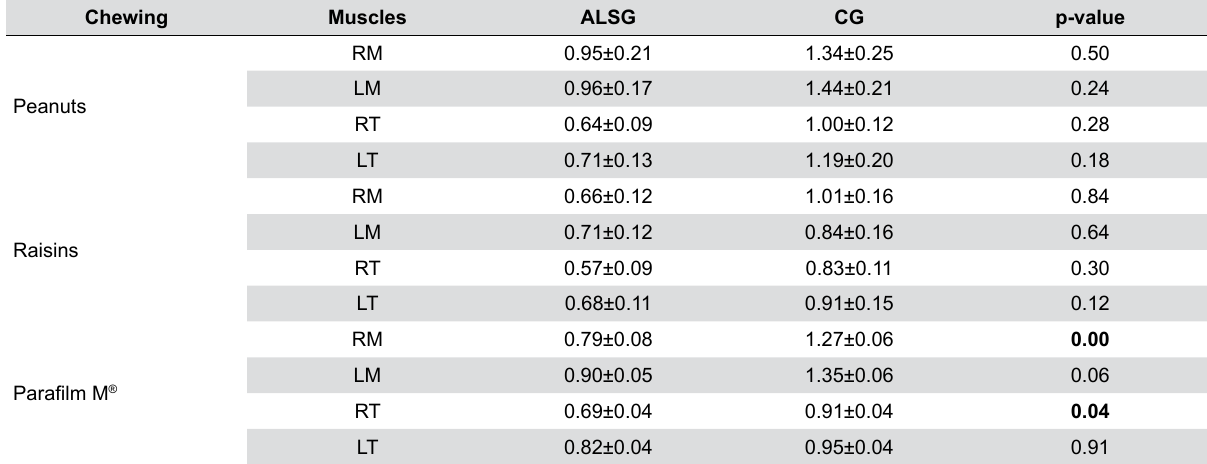
Table 3- Comparison of the mean habitual and non-habitual chewing data according to the groups. ALSG: Amyotrophic lateral sclerosis group; CG: control group; SD: standard deviation; RM: right masseter; LM: left masseter; RT: right temporal; LT: left temporal. Statistical significance was calculated using t test (p≤0.05). Significant p-values are indicated in